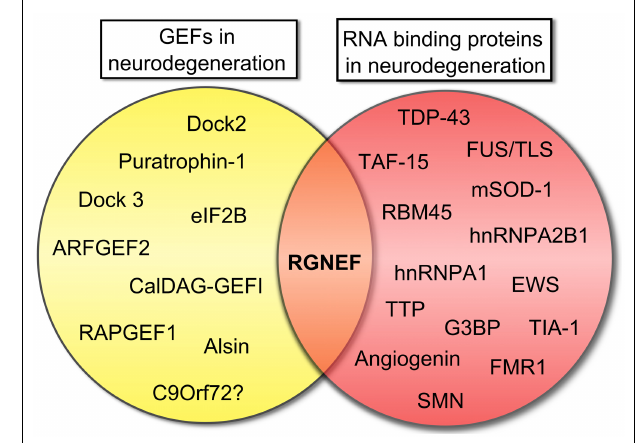
FIGURE 4 | Rho guanine nucleotide exchange factor (RGNEF) is the only GEF involved in neurodegeneration that also contains a RNA binding domain. Scheme showing the participation of several GEFs in neurodegeneration as was described in this review and RNA binding proteins that participate in neurodegeneration (Ge etal., 2005; Vanderweyde etal., 2013). RGNEF is the only protein involved in neurodegeneration that can be grouped in both categories. Abbreviations are: ARFGEF2, ADP-ribosylation factor GEF protein; CalDAG-GEFI, calcium and diacylglycerol-regulated GEFI; Dock2, Dedicator of cytokinesis 2; Dock3, Dedicator of cytokinesis 3; eIF2B, eukaryotic initiation factor 2B; EWS, Ewing sarcoma breakpoint region 1 protein; FMR1, Fragile X mental retardation protein 1; FUS/TLS, Fused in sarcoma/Translocated in liposarcoma; G3BP, Ras-GTPase-activating protein SH3-domain-binding protein; hnRNPA1, heterogeneous nuclear ribonucleoprotein A1; hnRNPA2B1, heterogeneous nuclear ribonucleoprotein A2/B1; mSOD1, mutant superoxide dismutase 1; RAPGEF1, Ras-related protein GEF1; RBM45, RNA binding motif protein 45; RGNEF, Rho guanine nucleotide exchange factor; SMN, Survival motor neuron protein;TAF15,TATA-binding protein-associated Factor 15;TDP-43,TAR DNA binding protein;TIA-1,T-cell intracellular antigen